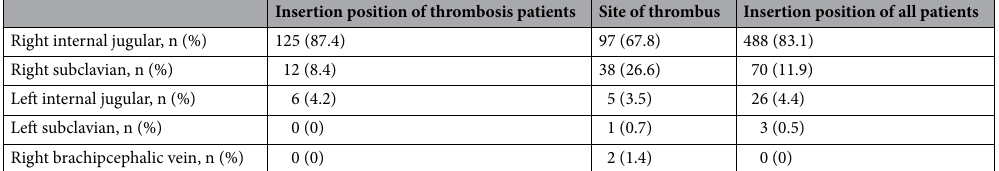
Table 2. Sites of TIAPs-associated thrombosis in pediatric oncology patients.